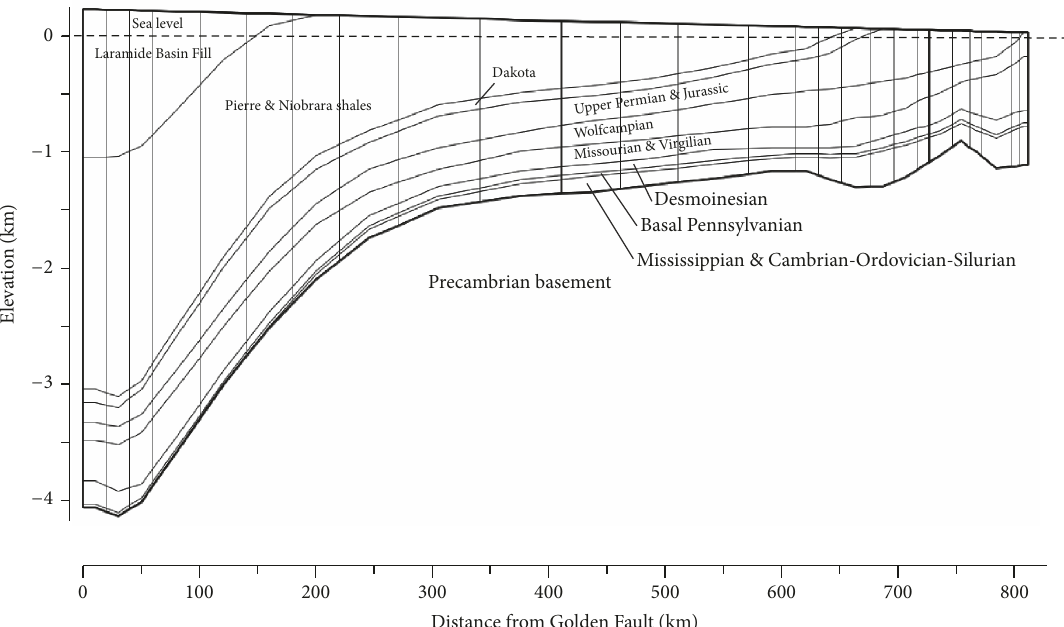
Figure 14: Grid of the first model of the sequence, having the geometry at 27 Ma, used to model the period from 40 to 27 Ma.